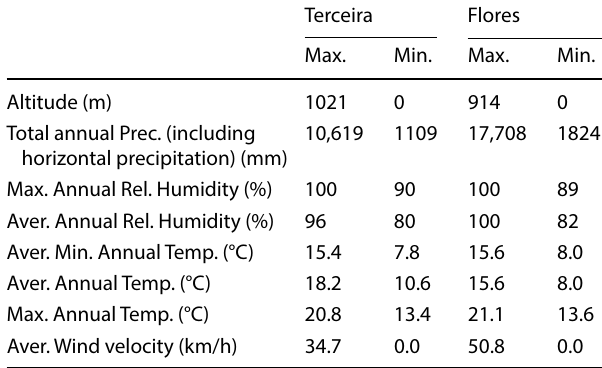
Table 1 Clime characterisation of Terceira and Flores Islands. Infor- mation based on Dias et al. [39]; Pereira [40] and Climaat webpage (in www. clima at. angra. uac.